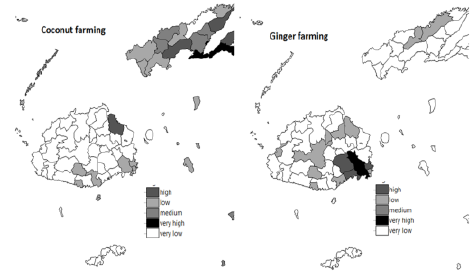
Figures 5a. Fiji islands map showing degrees of coconut farming per tikina . Range: 0 to 405 workers. Figure 5b. The country‘s map showing degrees of ginger farmers per tikina. Range: 0 to 107 workers.